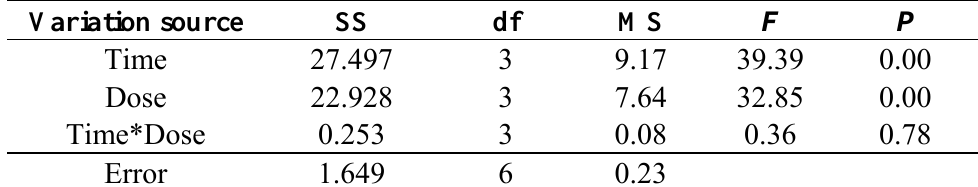
Table 5. ANOVA of positive cells of